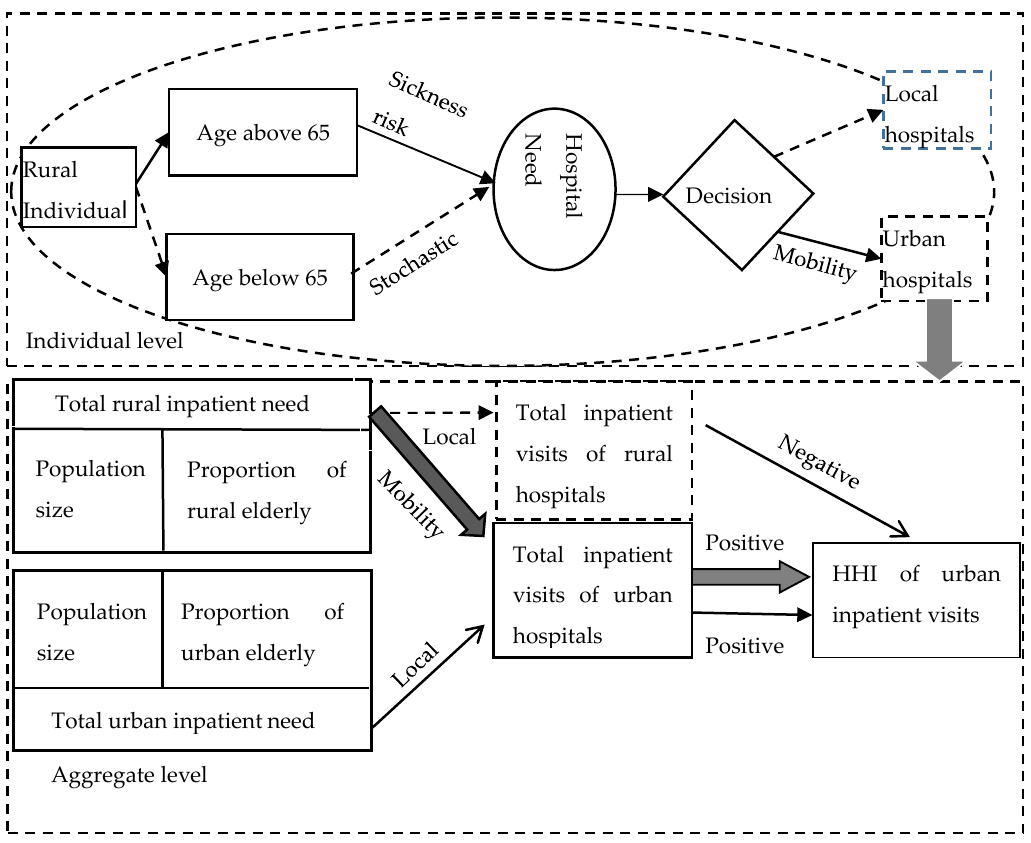
Figure 3. Ecological foundation of the aggregate level medical choice model.